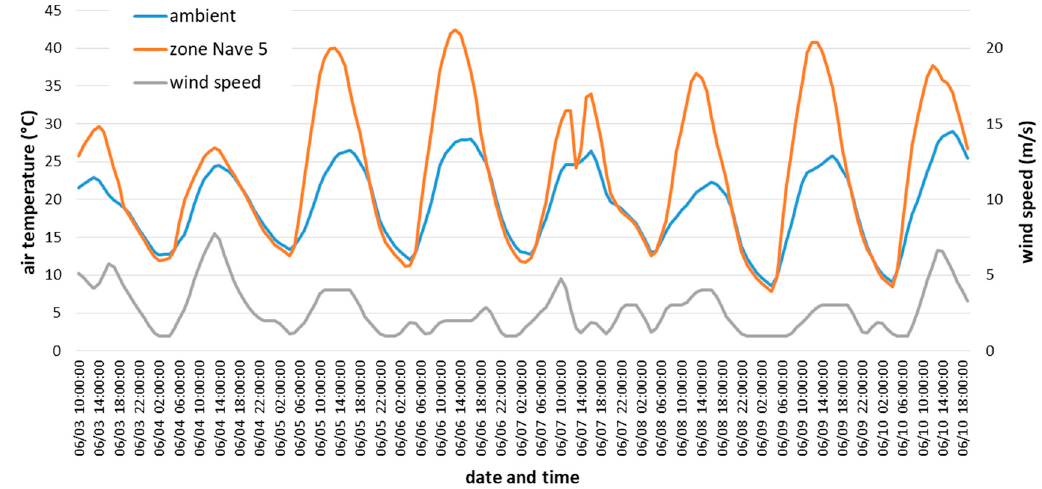
Figure 7. Simulated course of air temperature in the uppermost part of the attic space (zone Nave_5).